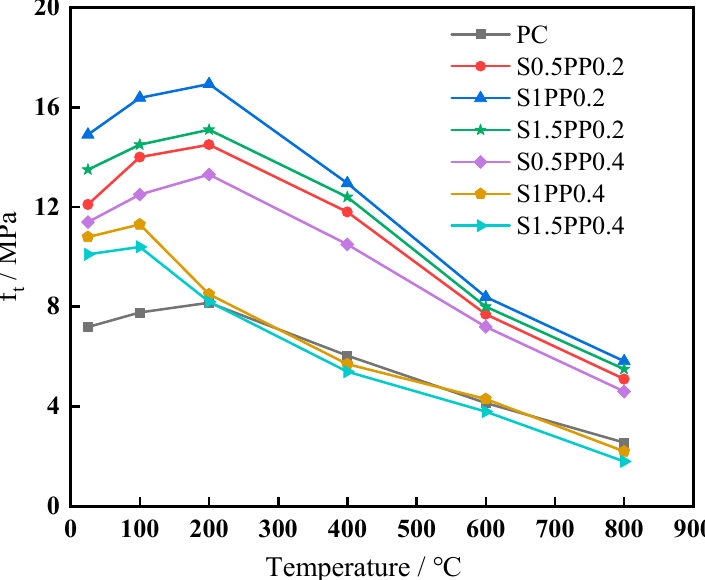
Figure 7. Relationship between the splitting tensile strength and the temperature of a specimen.